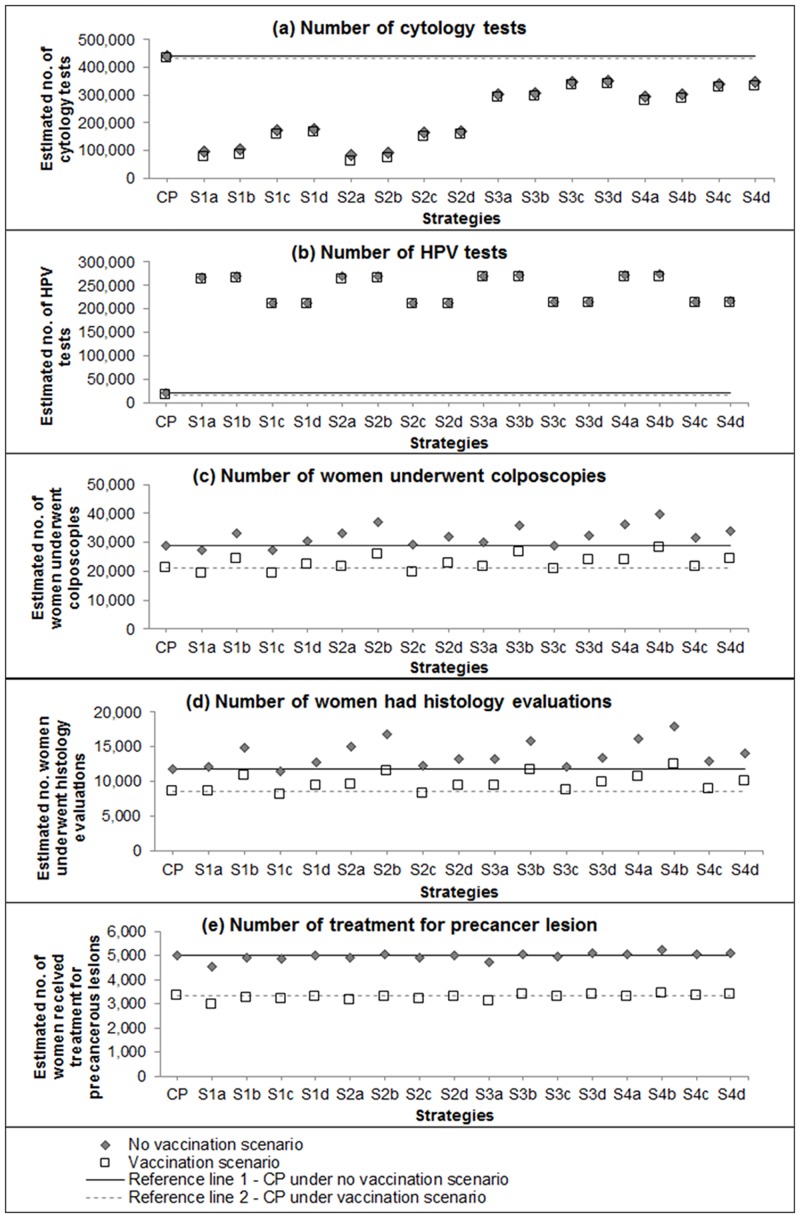
Model-predicted resource utilisation for all, assuming 2017 Australian female population.